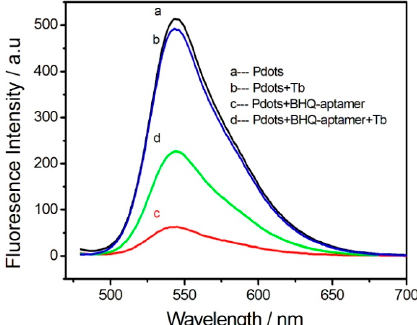
Figure 4. Fluorescence emission spectra of functionalized Pdots in HEPES buffer (20 mM, pH 7.4) upon addition of BHQ-TBA, thrombin. ( a ) 0.5 mg/mL functionalized Pdots; ( b ) 0.5 mg/mL functionalized Pdots after adding 20 nmol/L thrombin; ( c ) 0.5 mg/mL functionalized Pdots after adding 130 nM BHQ-TBA; ( d ) The functionalized Pdots-BHQ-TBA system after adding 20 nM thrombin in HEPES buffer. Excitation was performed at 455 nm.